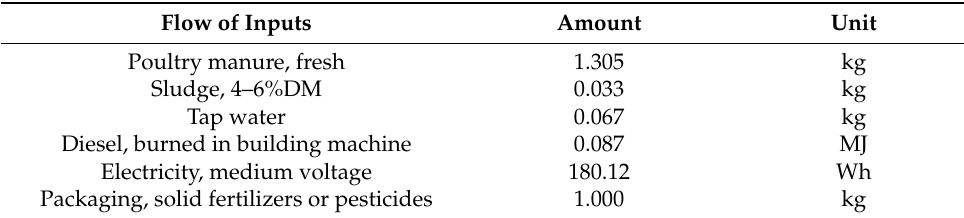
Table 3. The flow inputs per kilogram of composted pelletized poultry litter end